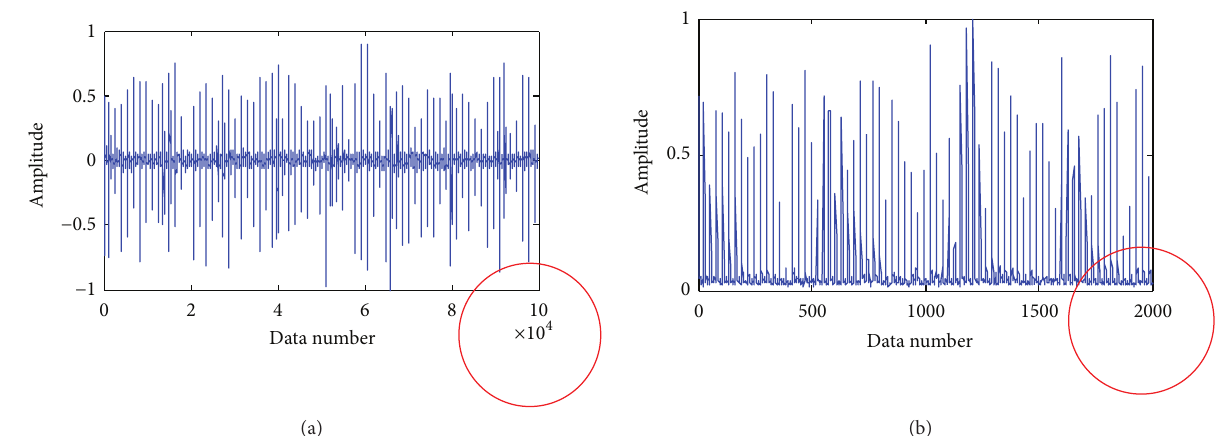
Figure 5: (a) Original signals and (b) symptom parameter wave using peak-to-peak value.